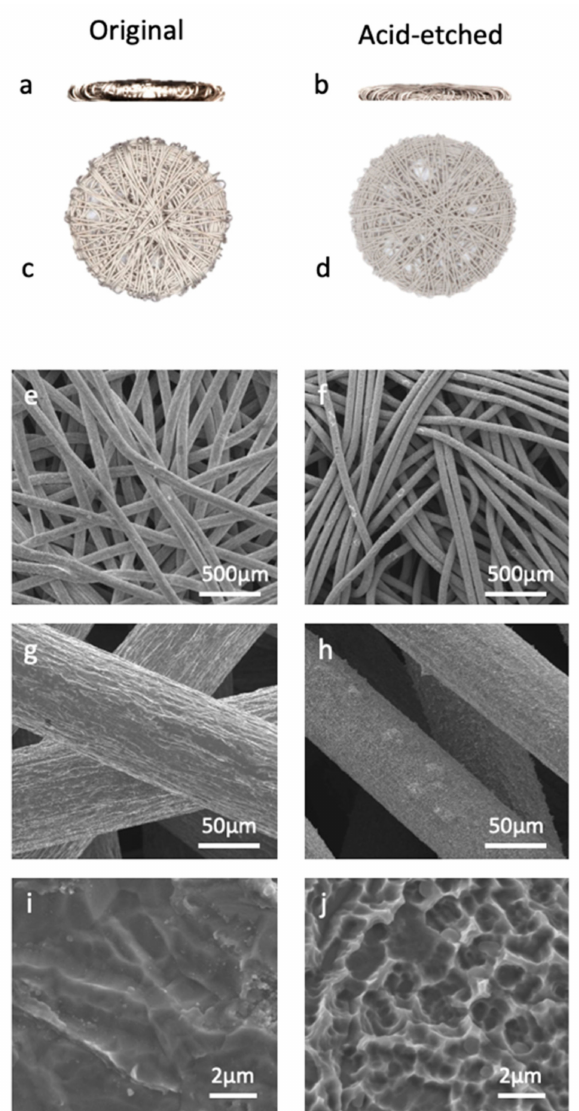
Figure 1. Creation of Ti microfiber sca ff olds and morphology of the surface. Top view of ( a ) original and ( b ) acid-etched disks, and side view of ( c ) original and ( d ) acid-etched disks. Scanning electron microscopy images of the original Ti microfibers ( e , g , i ) and the acid-etched Ti microfibers ( f , h , j